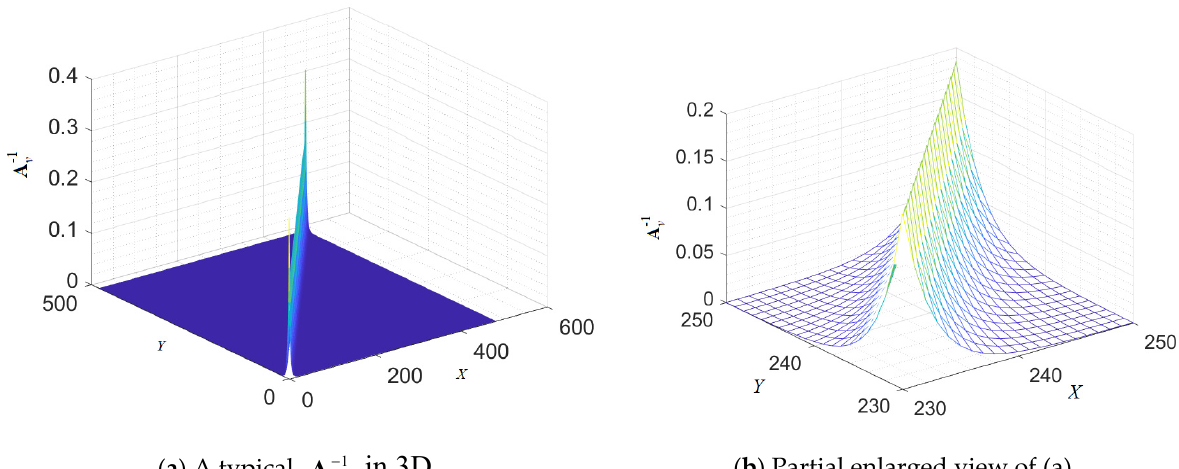
Figure 2. Two-dimensional visualization of a typical A − 1 v ( M = 480, N = 720, and λ = 7), where lighter colors represent higher values. ( a ) is the entire matrix and ( b ) is a partial view of ( a ) with the length enlarged by a factor of 16.